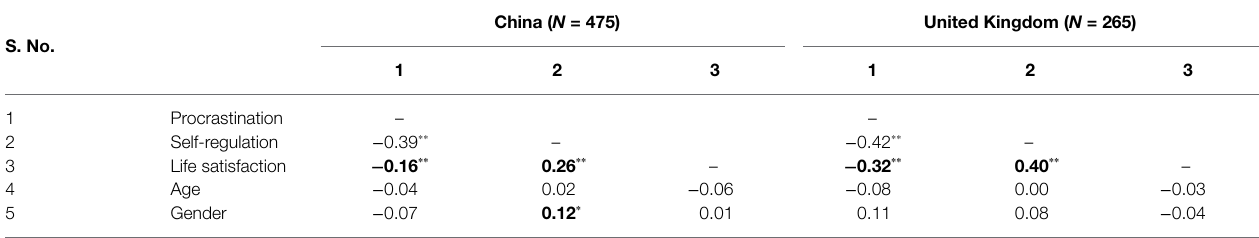
TABLE 2 | Pearson product–moment correlations.